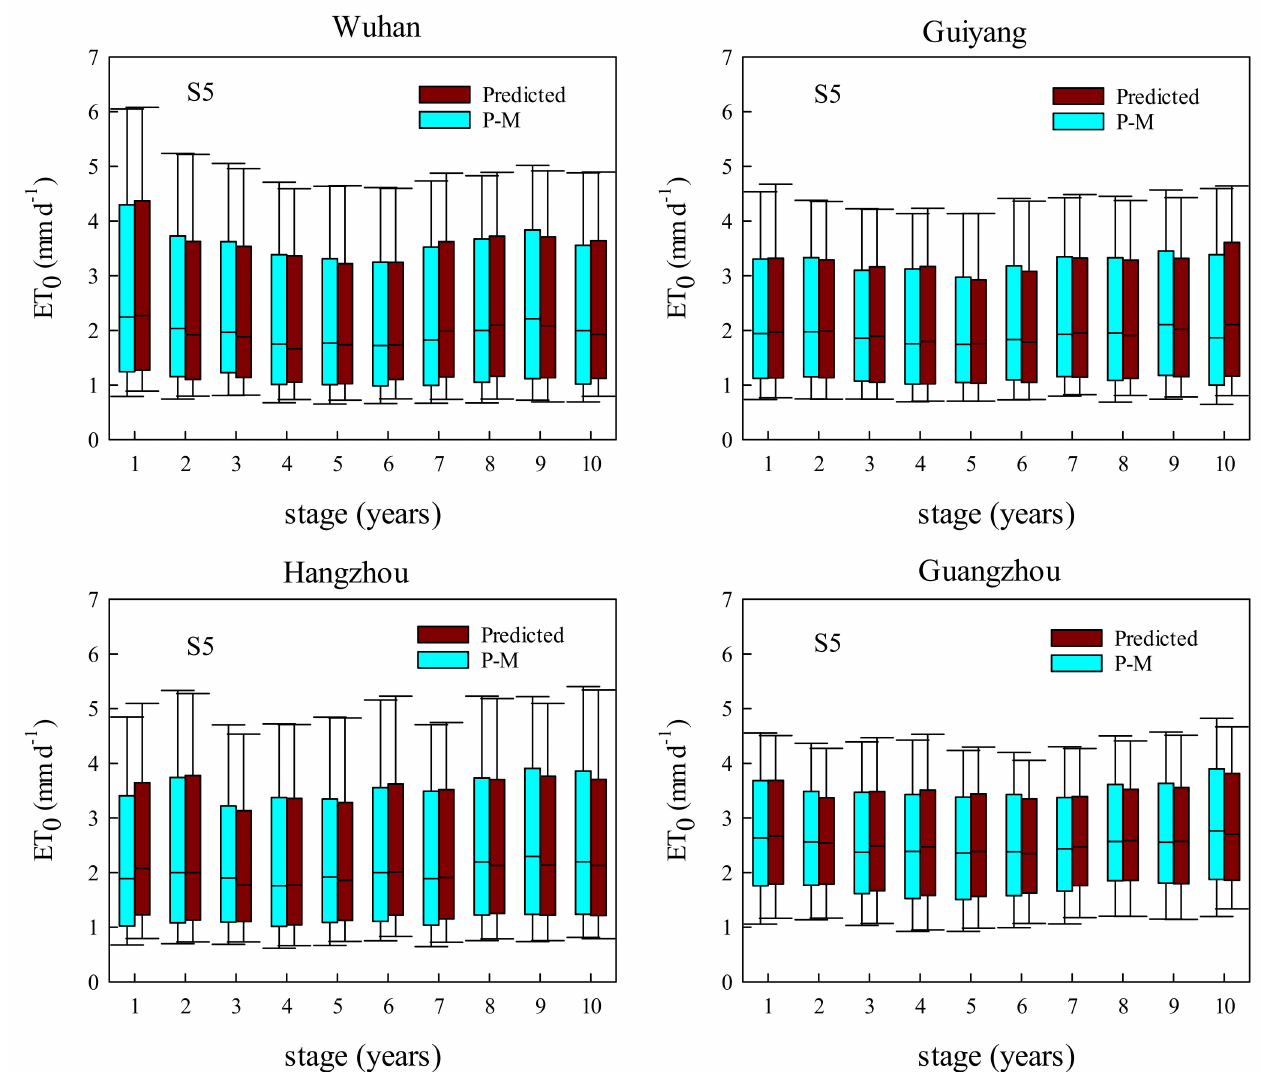
Figure 5. Box diagrams of daily FAO56-PM ET 0 values and predicted ET 0 values by the S5 proportion during ten cross- validation stages using the perfect dataset in the testing stage (1966–2015) at the four weather stations. The numbers on the horizontal direction represent the 10 cross-validation periods at S5 proportion,